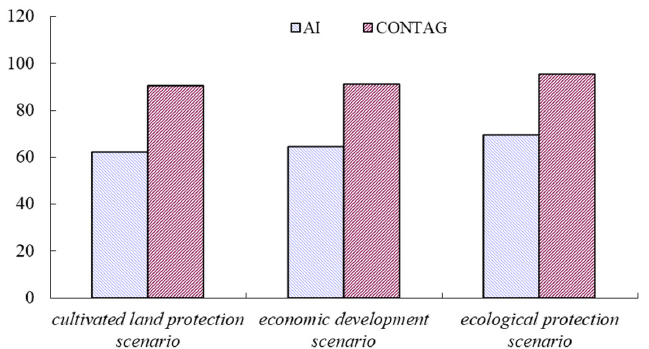
Figure 6. Comparison of landscape index under three scenarios in Suzhou.